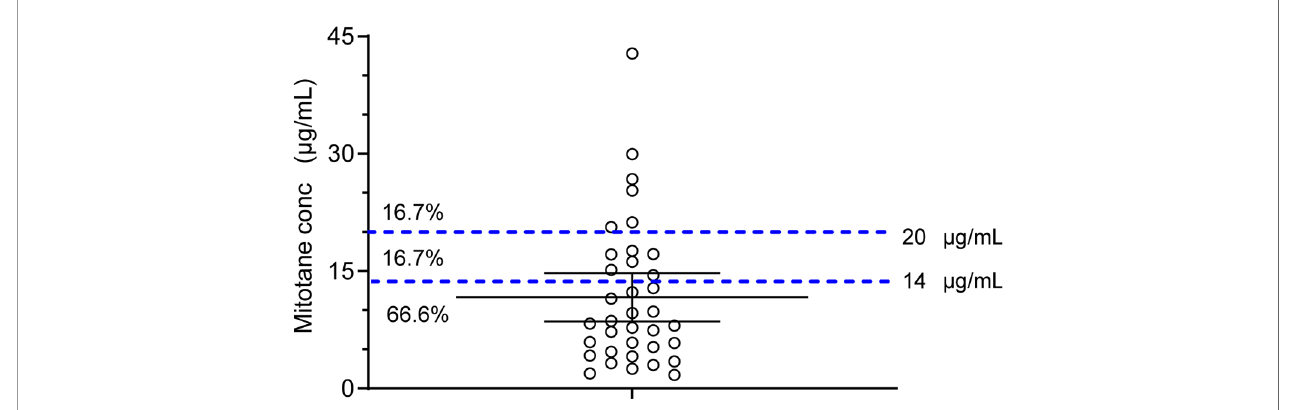
FIGURE 2 | Scatter dot plot of mitotane plasma trough concentrations. Dashed lines represent the concentration therapeutic window. Percentages of samples below, within, or above the therapeutic concentrations are